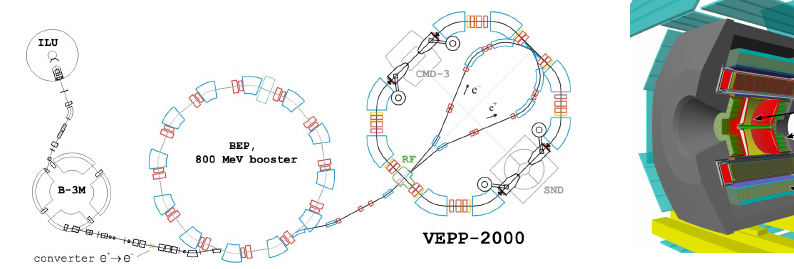
Figure 2. Sketch of the CMD-3 detec-